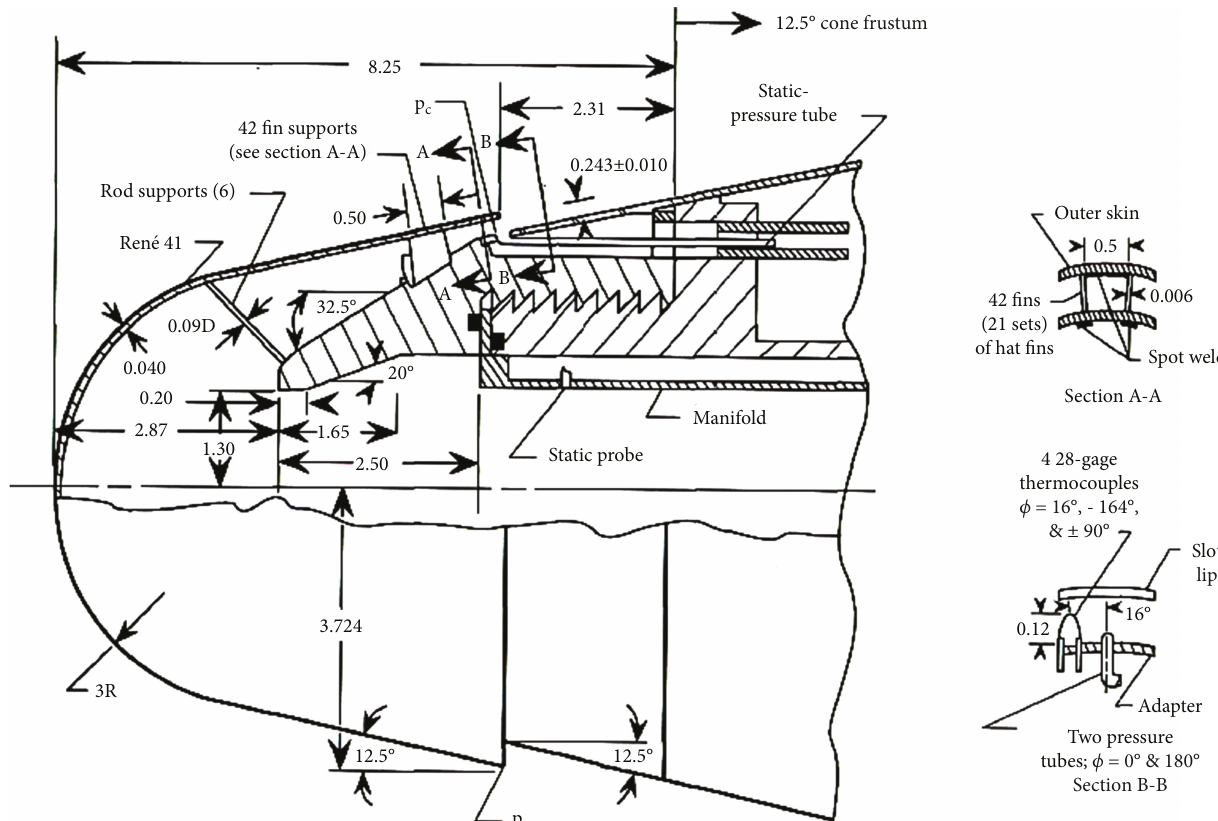
Figure 2: Tangent-slot blowing model, Nowak [20].